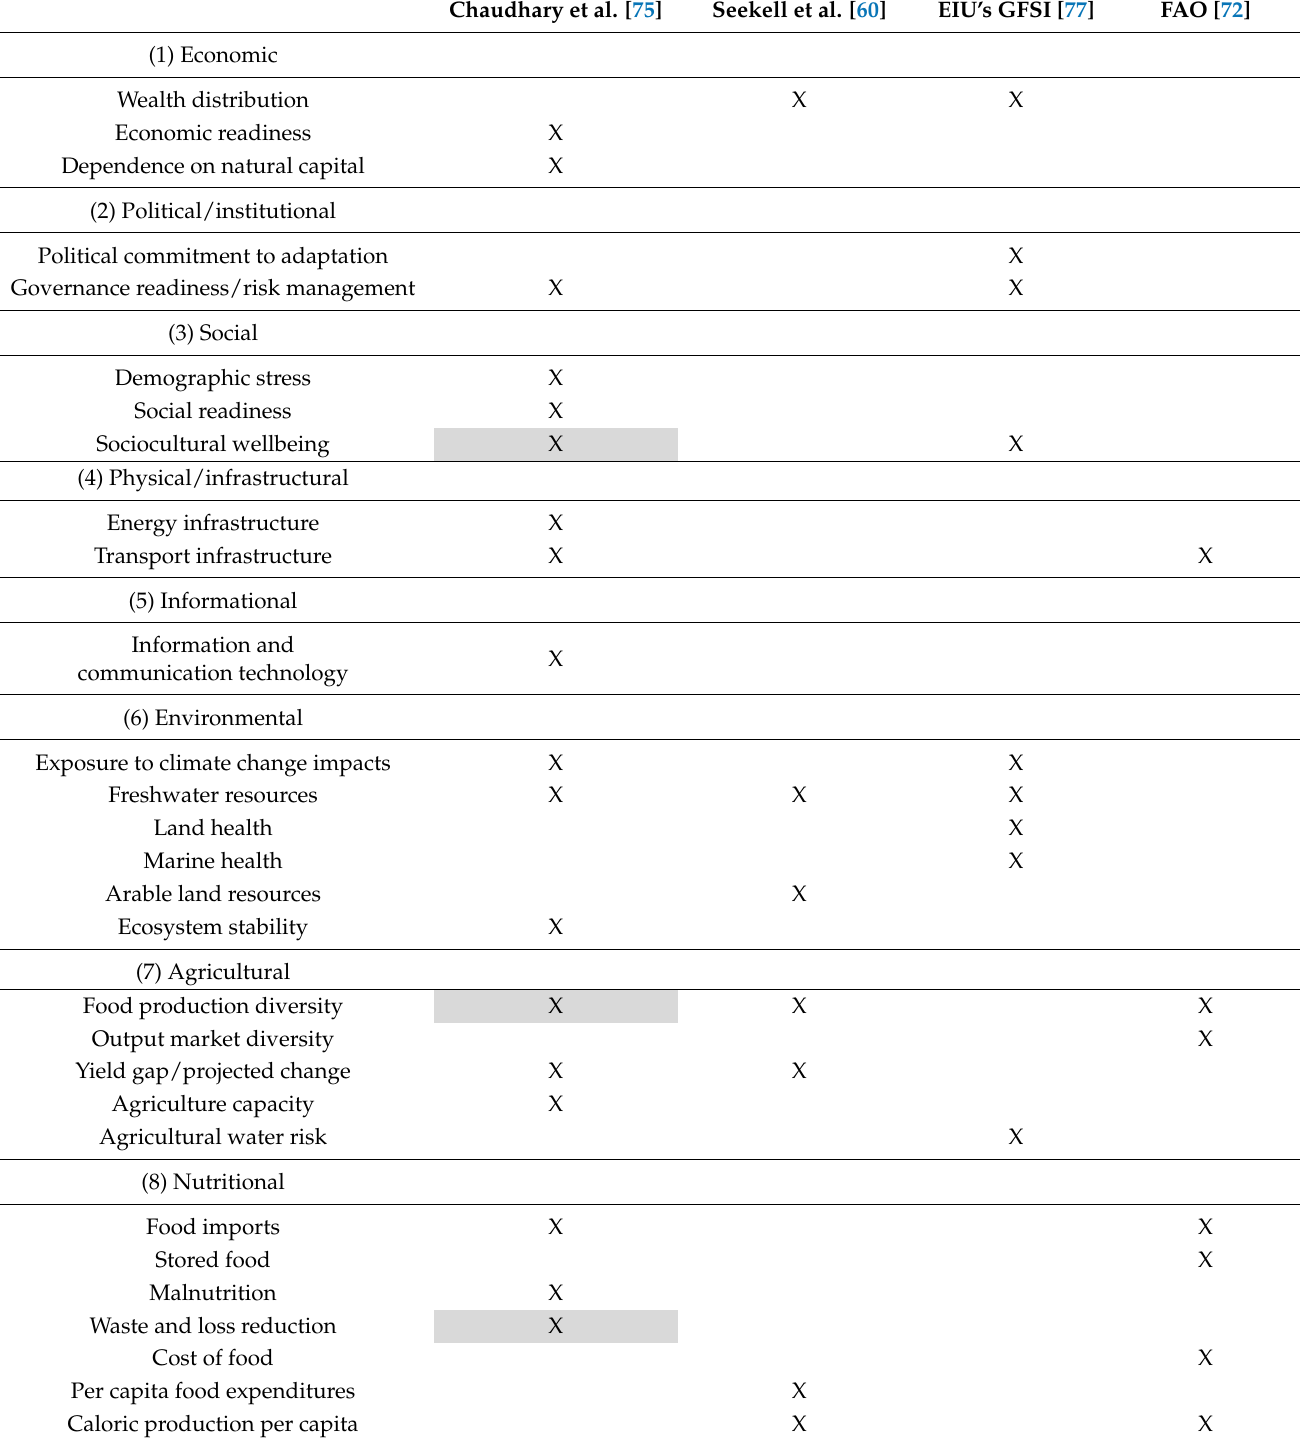
Table 2. Resilience elements in national-level measurement